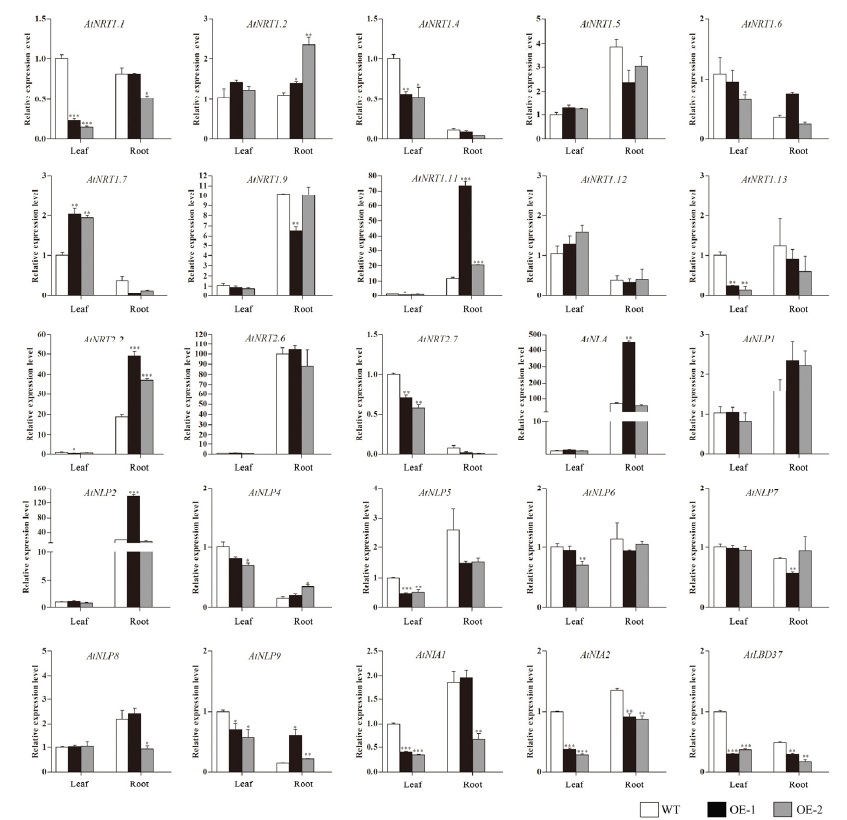
Figure 7. The expression levels of nitrate response related genes in WT and transgenic Arabidopsis plants hosting CsLBD39 gene. The data are expressed as mean ± standard deviation of three biological replicates ( n = 3). AtSAND was used as reference gene. Asterisks (*) indicate that the value is significant difference compared to the WT (* p < 0.05; ** p < 0.01; *** p < 0.001). The expression levels of nitrate transport genes AtNRT1.1 , AtNRT1.4 , AtNIA2 , AtNRT1.7 and nitrate response TFs AtNLP5 , AtLBD37 in transgenic Arabidopsis roots were lower than WT. The expression levels of nitrate transport related genes AtNRT1.11 , AtNRT2.2 and nitrate response TFs AtNLP2 , AtNLP4 and AtNLP9 in transgenic Arabidopsis roots were significantly higher than WT. These results suggested that overexpression of CsLBD39 gene leads to changes in the expression of nitrate responsive genes in Arabidopsis plants. 2.8. Analysis of Nitrate, Anthocyanins and Chlorophyll Contents in Transgenic Arabidopsis Overexpressing CsLBD39 under Nitrate Treatment A detailed summary of Arabidopsis growth and treatment conditions is shown in Fig- ure 8A, the WT and transgenic Arabidopsis were grown in the cultivation medium for 25 d and then transferred to KCl and KNO 3 hydroponic nutrient solution for seven days (Fig- ure 8B). The nitrate content in the leaves of the transgenic lines decreased after treatment, and the nitrate content under the KNO 3 treatment was higher than that under the KCl treatment at seven days (Figure 9A). The same trend was observed in roots. The nitrate content in the roots of the transgenic plants was significantly reduced after treatment for seven days, the nitrate content in Arabidopsis roots under the KNO 3 treatment was higher than that under the KCl treatment (Figure 9B). Nitrogen deficiency in plants will cause stress responses, which will affect the synthesis of anthocyanins. The anthocyanins